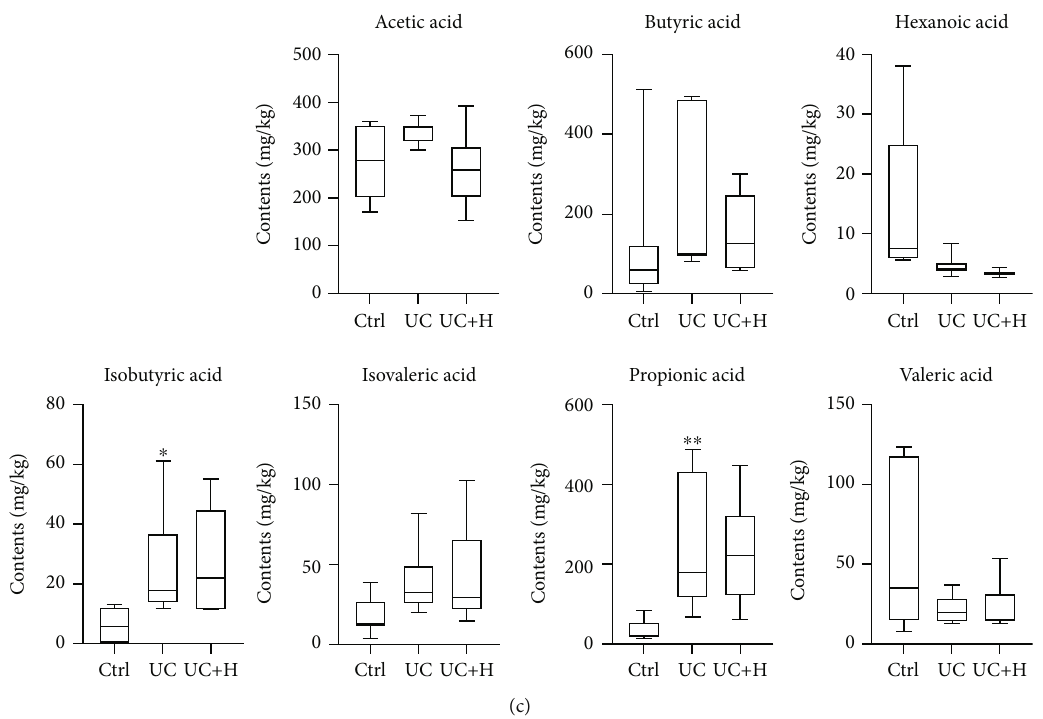
Figure 4: Qinghua Jianpi Recipe can regulate short-chain fatty acid metabolism of intestinal bacteria in mice with colorectal adenoma cancer model. The TIC chromatograms (a), PCA (b) and concentration (c) of the short-chain fatty acids in fecal samples. ∗ P < 0 : 05 and ∗∗ P < 0 : 05 , the di ff erence was statistically signi fi